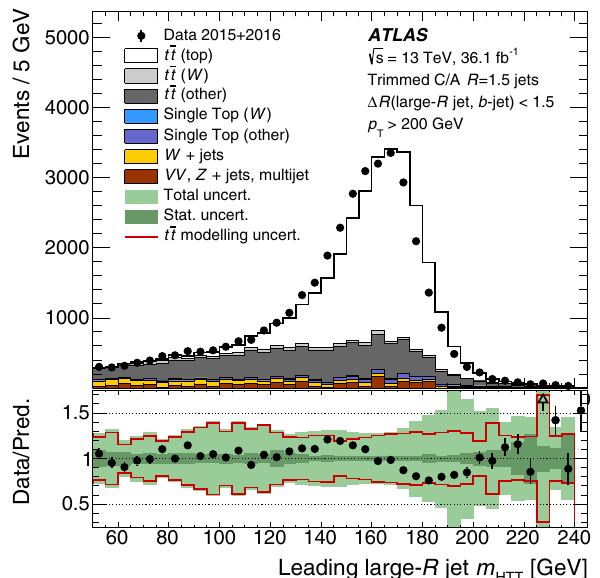
Fig. 15 A comparison of the observed data and predicted MC distri- butions of the HEPTopTagger mass for the top-quark event selection in a sample enriched in lepton-plus-jets t ¯ t events. Simulated distributions are normalised to data. The t ¯ t sample is divided into a set of subsam- ples (e.g. t ¯ t (top)) based on criteria described in Sect. 4.2. The statistical uncertaintyofthebackgroundprediction(Stat.uncert.)resultsfromlim- ited Monte Carlo statistics as well as the limited size of the data sample used in the data-driven estimation of the multijet background